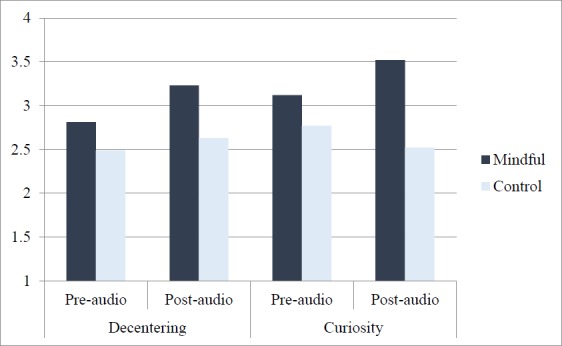
The effect of mindfulness condition on TMS subscales as a function of presentation order.